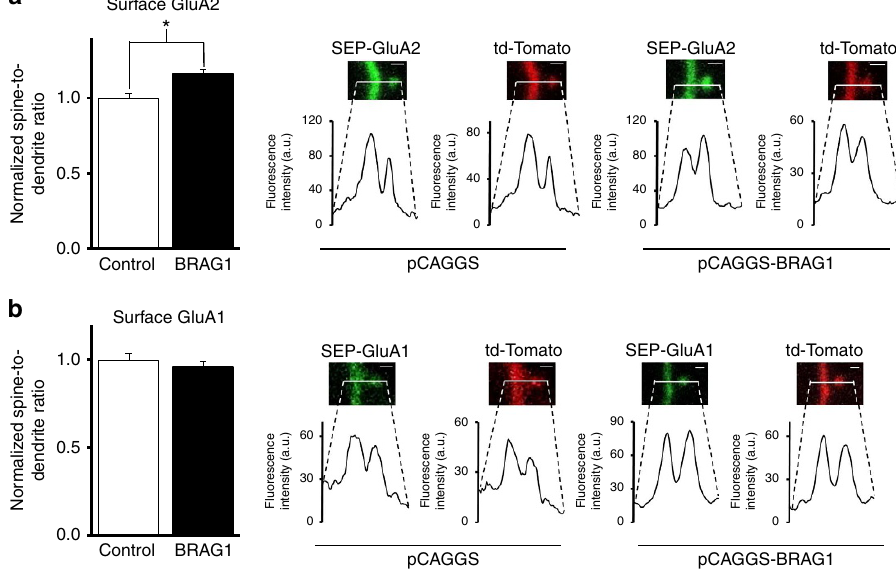
Figure 6 | BRAG1 increases surface GluA2 but not GluA1. ( a ) Left: Data represent the average normalized spine-to-dendrite ratios of SEP-GluA2 in the presence and absence of BRAG1. Right: representative confocal images of SEP-GluA2 and td-Tomato co-expressed with either pCAGGS (left, n ¼ 114) or pCAGGS-BRAG1 (right, n ¼ 73). ( b ) Left: data represent the average normalized spine-to-dendrite ratios of SEP-GluA1 in the presence and absence of BRAG1. Right: representative confocal images of SEP-GluA1and td-Tomato co-expressed with either pCAGGS (left, n ¼ 102) or pCAGGS-BRAG1 (right, n ¼ 102). * Indicates significance ( P r 0.05). Scale bars, 1 m